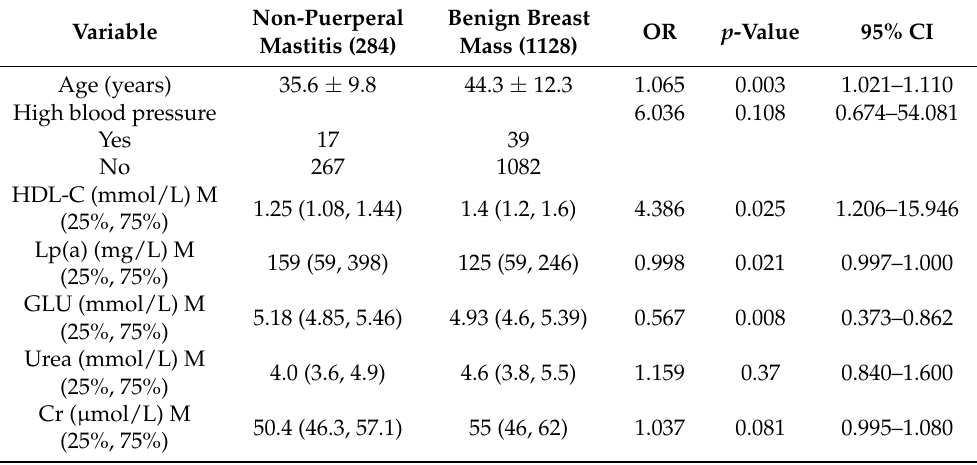
Table 3. Multivariate logistic regression analysis of selected risk factors between non-puerperal mastitis and benign breast